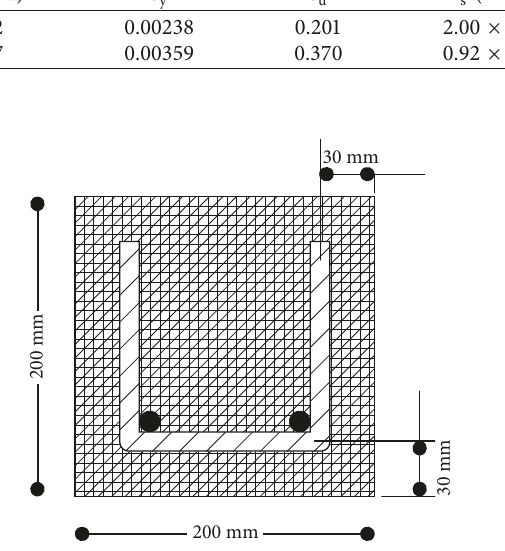
Figure 3: Cross section of RC beam specimens reinforced by steel and hybrid rebars used in this , δ , P , and δ denote y y u u